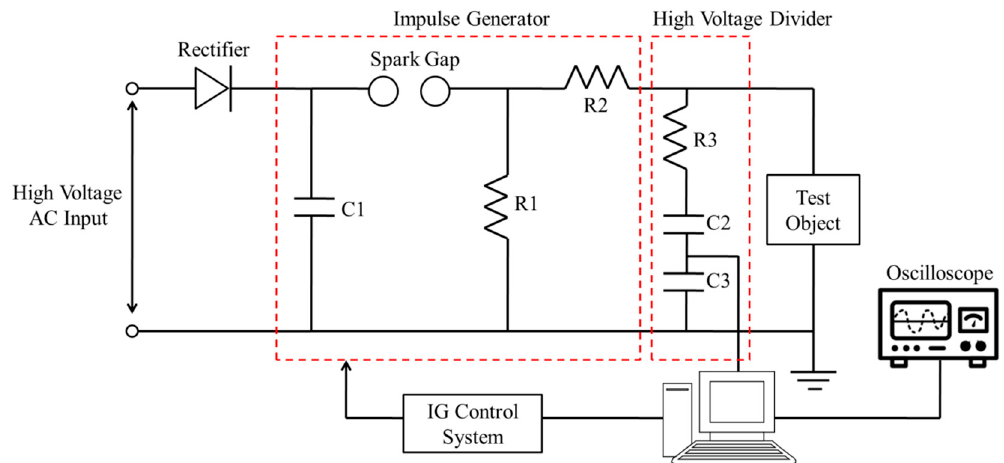
Figure 6. Schematic of lightning impulse measurement.